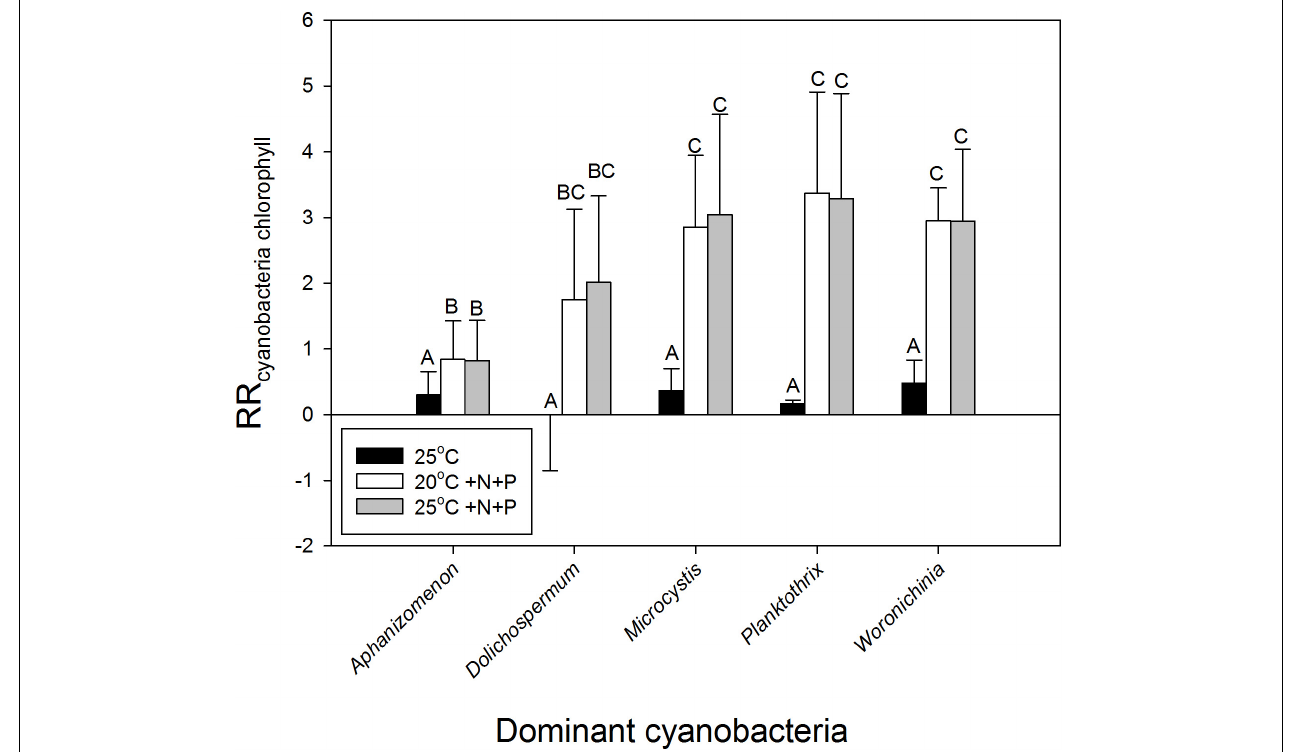
FIGURE 4 | Response ratios - natural logarithm of the quotient of cyanobacterial chlorophyll-a concentrations ( µ g l − 1 ) in warmed (25 ◦ C, black bars), nutrient enriched (20 ◦ C +N+P, open bars), or warmed + nutrient enriched (25 ◦ C +N+P, gray bars) incubations and the control incubations (20 ◦ C) – for waters in which at start of the experiments different cyanobacteria were dominant (genus level). Error bars indicate 1 SD, while similar letters indicate homogeneous groups (Tukey